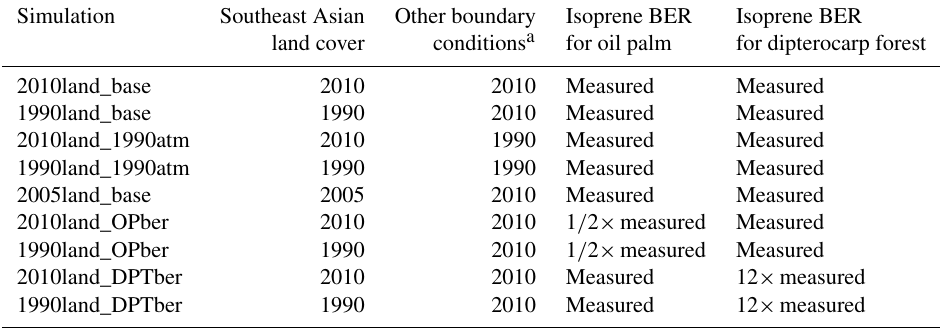
Table 3. Simulation